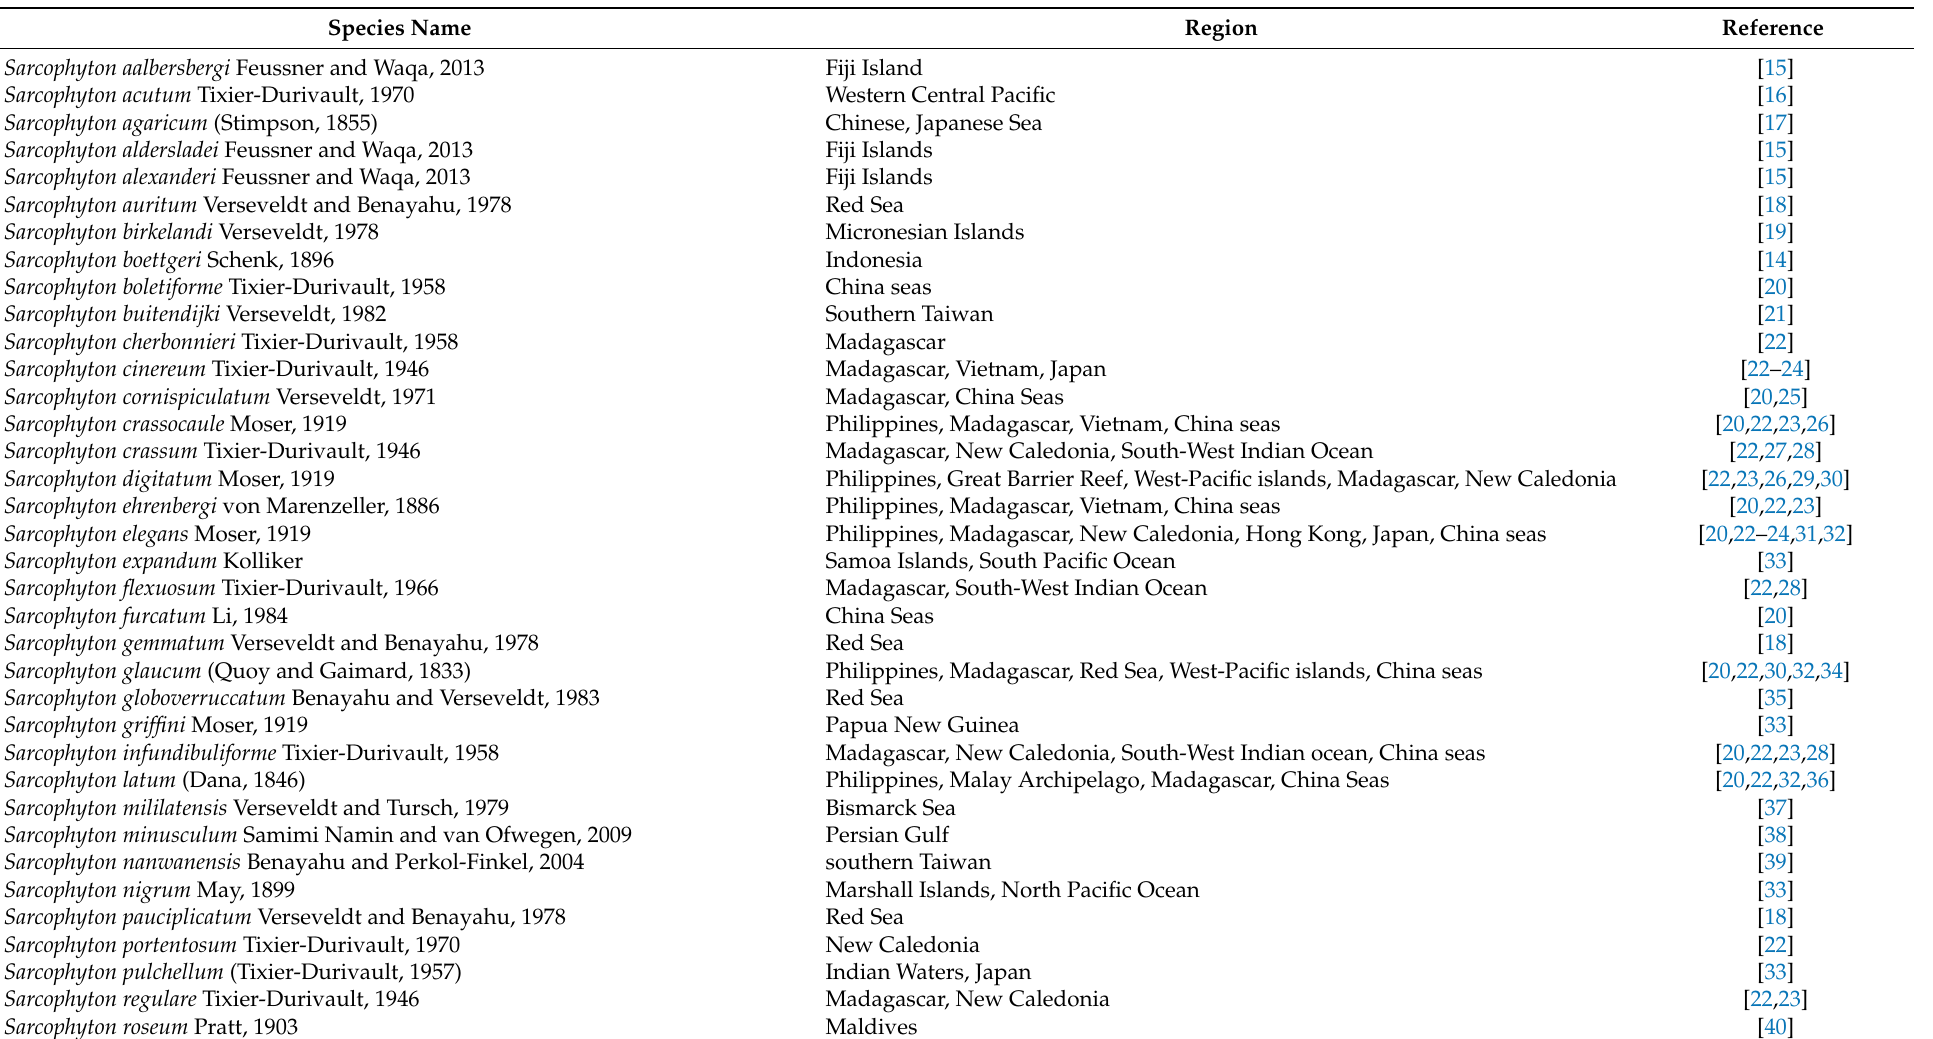
Table 1. Sarcophyton species